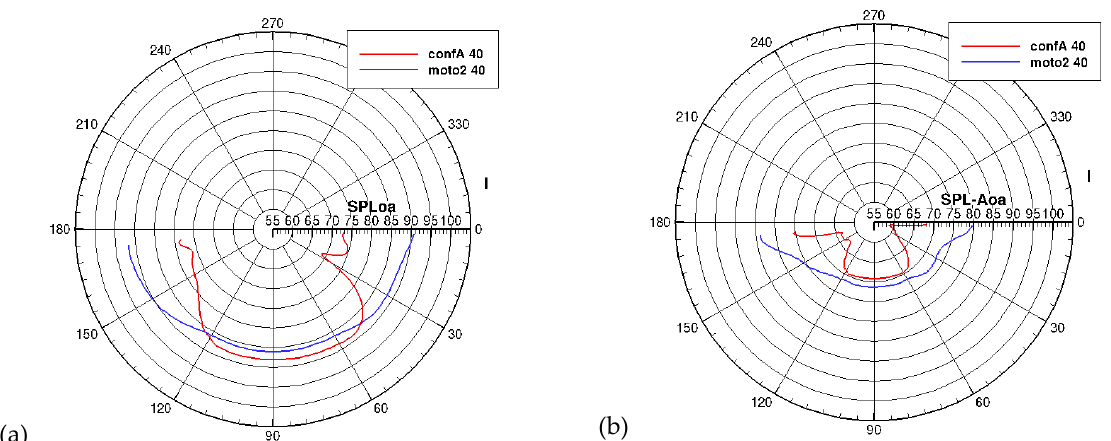
Figure 25. Comparison between Configuration A and Motorization 2; OASPL values on the horizontal XY plane ( a ), A-weighted values on ( b ). Flight condition Climb 100% ETR.